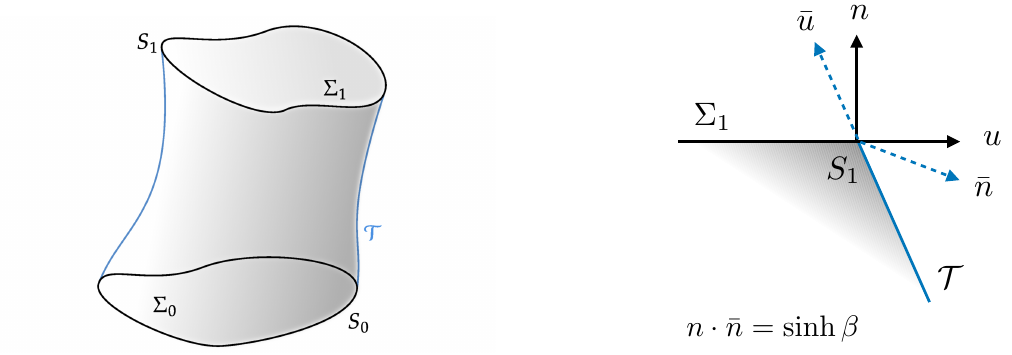
Figure 1 . Left panel: a finite region of spacetime and the notation used for the boundaries. Right panel: the four normals generically present at the corner, here the one in the future of T . Unbarred quantities refer to the space-like hypersurface, and barred quantities to the time-like one.